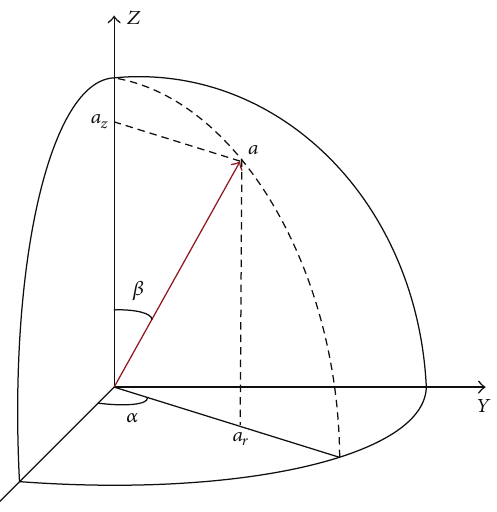
Figure 2: Schematic view of direction of shock acceleration.